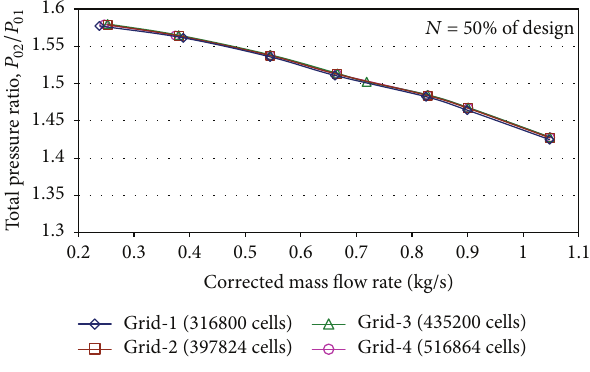
Figure 10: Grid independence